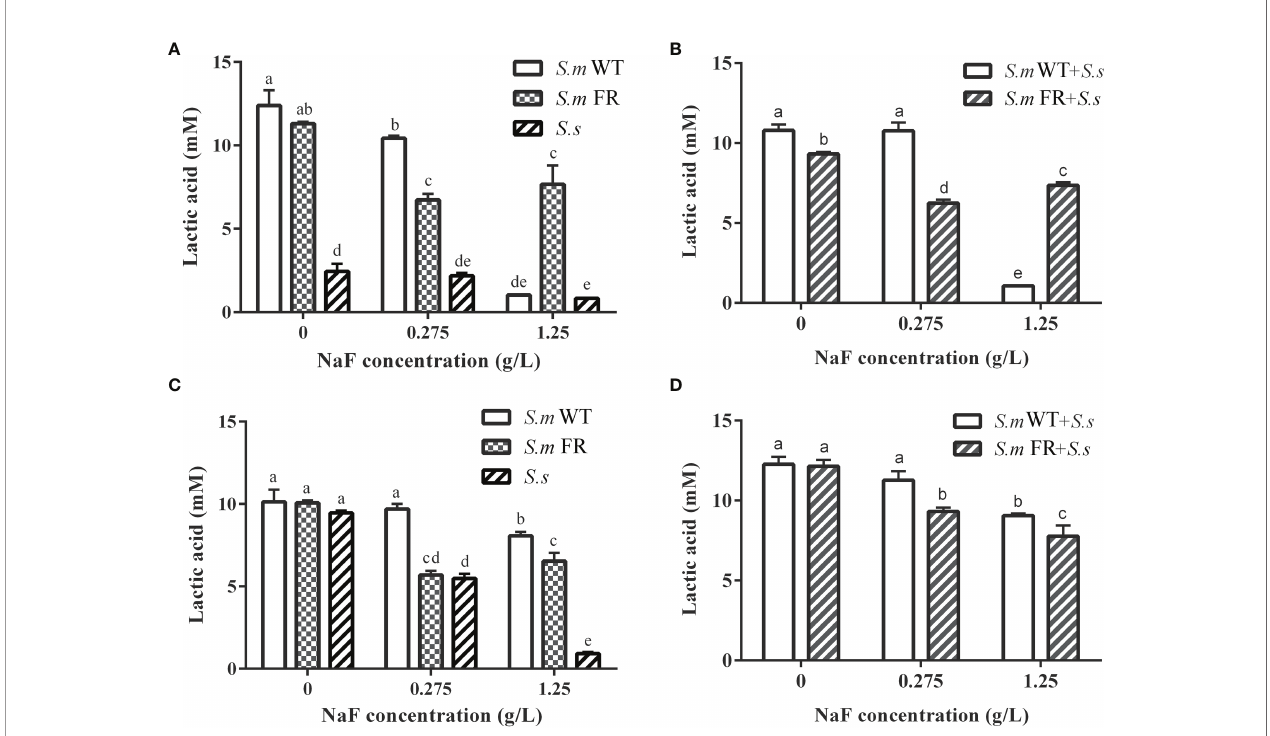
FIGURE 8 | Lactic acid production of bio fi lms. (A) Single-species bio fi lm formation. (B) Dual-species bio fi lm formation. (C) Pre-formed single-species bio fi lms. (D) Pre-formed dual-species bio fi lms. The same letters indicate no statistical difference, and different letters indicate a signi fi cant difference between groups ( P <